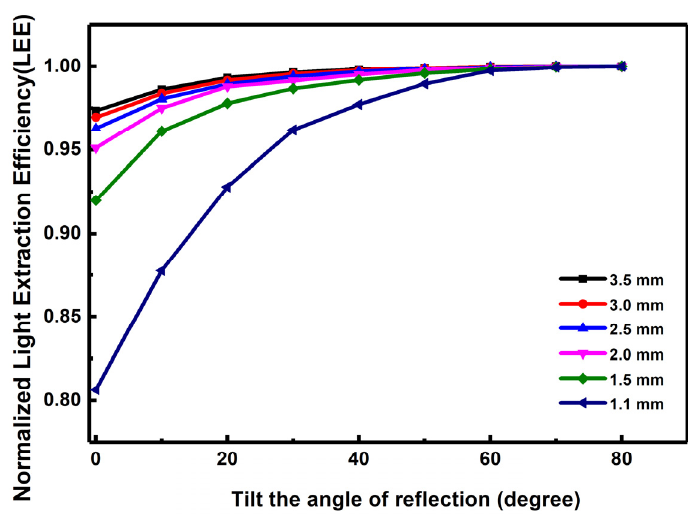
Figure 8. Simulated LEEs of DUV-LEDs with various tilt angles and cavity diameters.